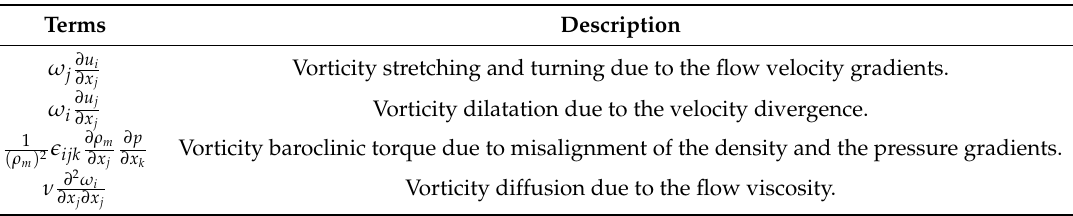
Table 1. Description of the vorticity transport equation